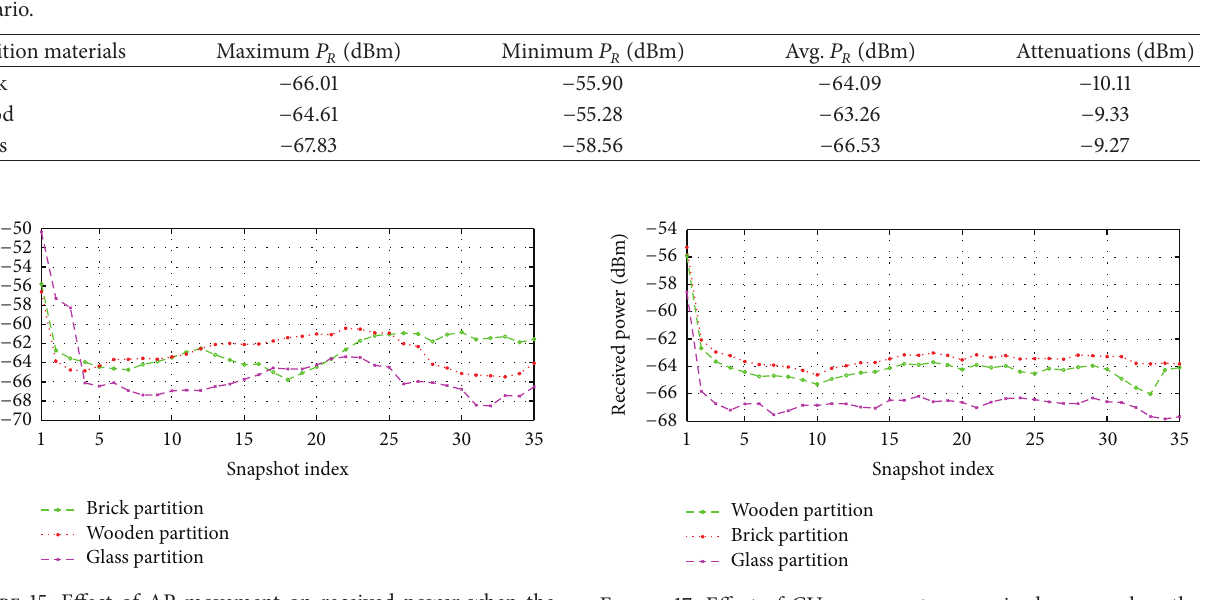
Figure 17: Effect of CU movement on received power when the results taken by considering the inside partitions (red colored) are made of either brick, wood, or